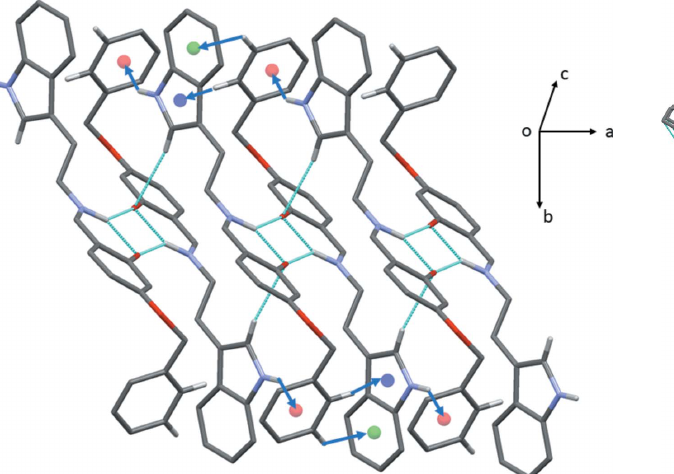
Figure 4 A view of the hydrogen bonds (dashed lines) and C—H (cid:2)(cid:2)(cid:2) (cid:2) and weak N—H (cid:2)(cid:2)(cid:2) (cid:2) interactions (blue arrows) in the crystal structure of compound (II); centroid Cg 1 is blue, centroid Cg 2 is green and centroid Cg 4 is red (see Table 2). Only the H atoms involved in these interactions have been included.